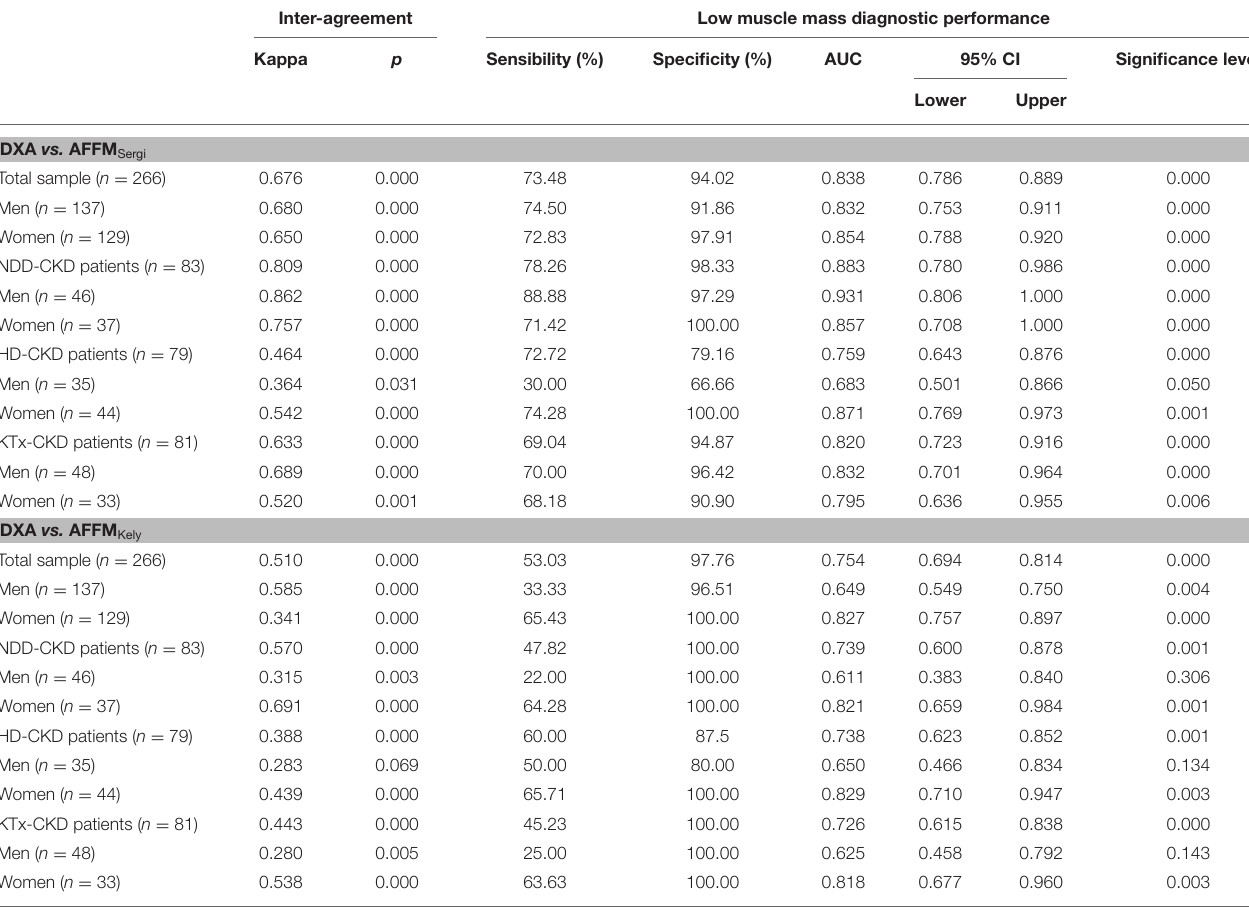
TABLE 6 | Reproducibility of AFFM prediction equations to evaluate low muscle mass compared to DXA as